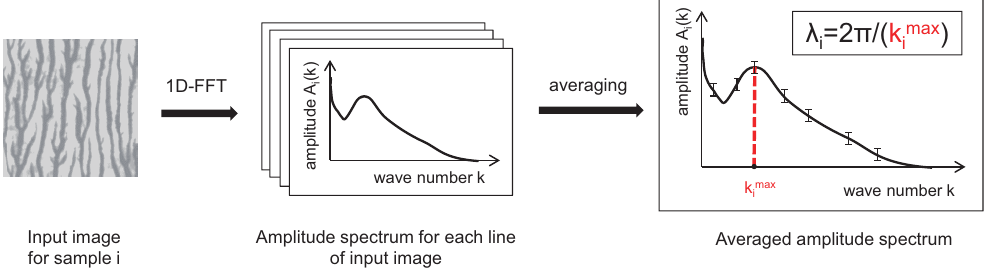
Figure A3. Measurement procedure for the dominant pattern wavelength λ i of each sample i . In the first step, a one-dimensional Fast Fourier Transform Algorithm (1D-FFT) is applied to each line of the input image in MATLAB 2018b. The 1D-FFT delivers n rows = 24,568 amplitude spectra. Each amplitude spectrum shows the spectral amplitudes A i ( k ) versus their wave numbers k . In the second step, a sample-averaged amplitude spectrum is calculated from which a clear maximum k max the predefined region of interest. Finally, the dominant pattern wavelength λ i is calculated from k max